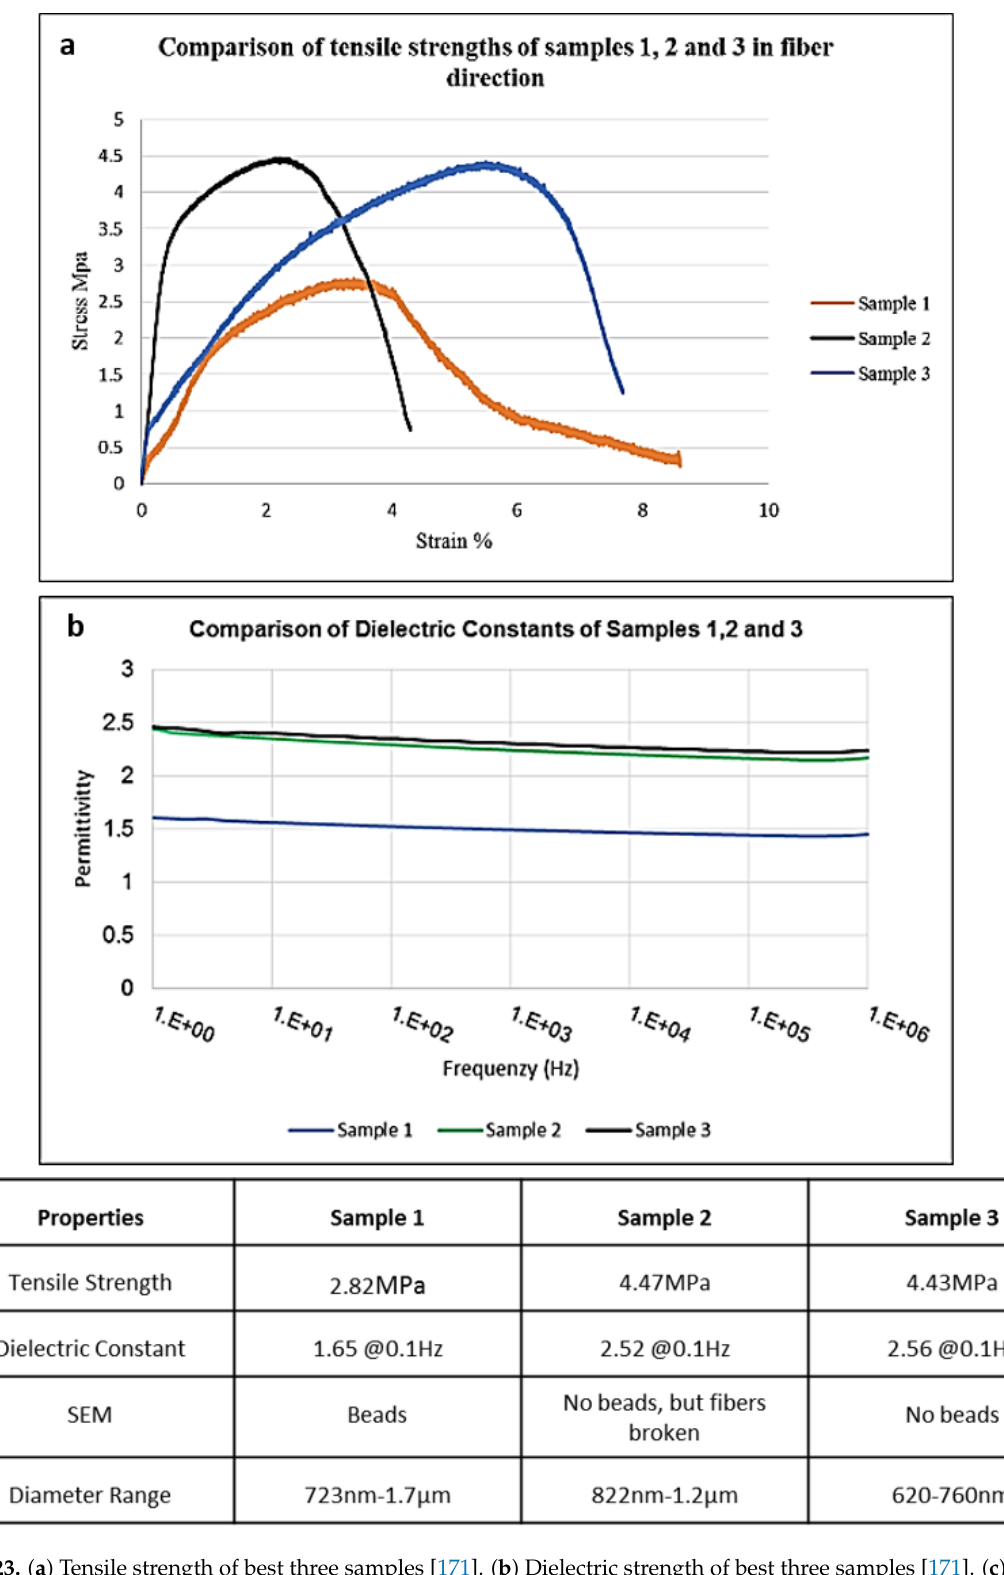
Figure 23. ( a ) Tensile strength of best three samples [ 171 ] . ( b ) Dielectric strength of best three samples [171]. ( c ) Tensile and dielectric properties of three samples [ 171 ] .